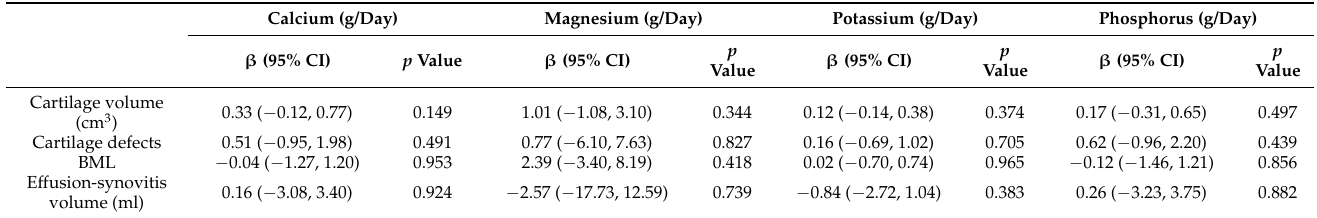
Table 2. Associations of macroelements with knee joint structures over 2